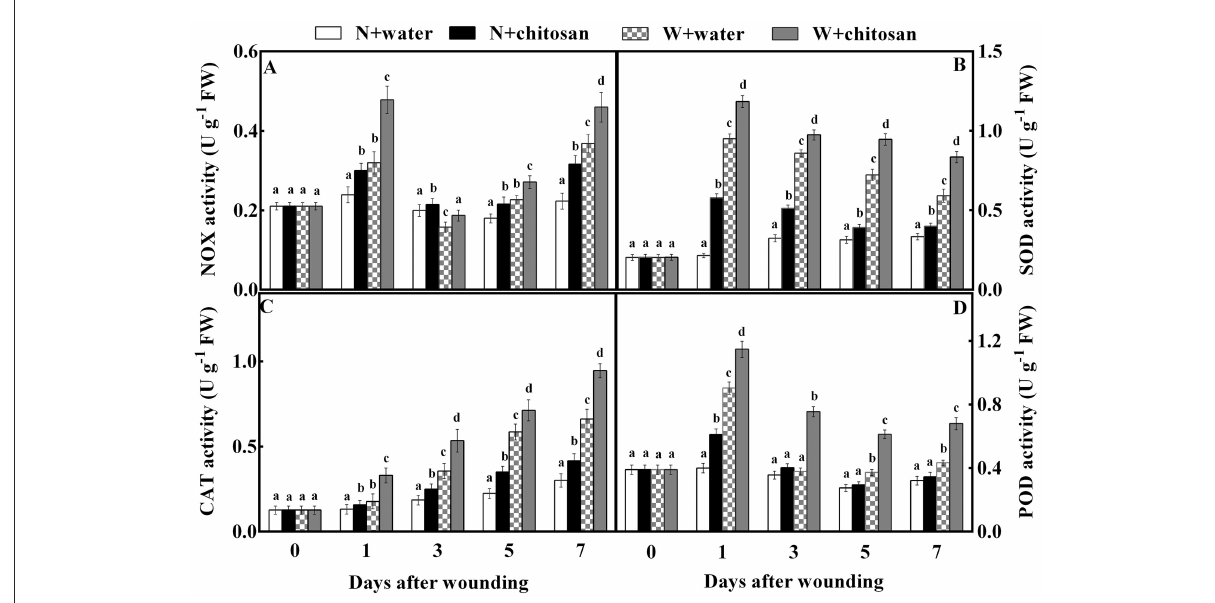
FIGURE3 Effect of chitosan treatment on the activities of NOX (A) , SOD (B) , CAT (C) , and POD (D ). Non-wounded fruit treated with sterile water (N + water), non-wounded fruit treated with chitosan (N + chitosan), wounded fruit treated with sterile water (W + water), and wounded fruit treated with chitosan (W + chitosan). Vertical bars indicate standard error of means. For each day after wounding, alphabets indicate significant differences ( P < 0.05).